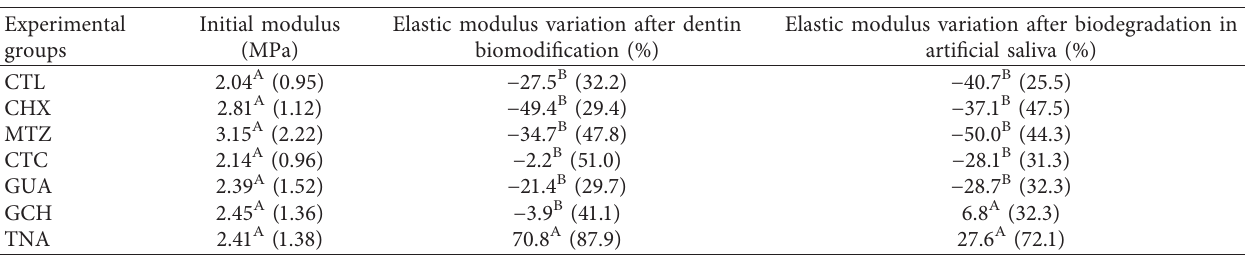
Table 5: Means (standard deviation) of modulus of elasticity (in MPa) of demineralized dentin as a function of the treatment. Experimental Elastic modulus variation after dentin Elastic modulus variation after biodegradation in groups biomodification (%) artificial saliva (%)